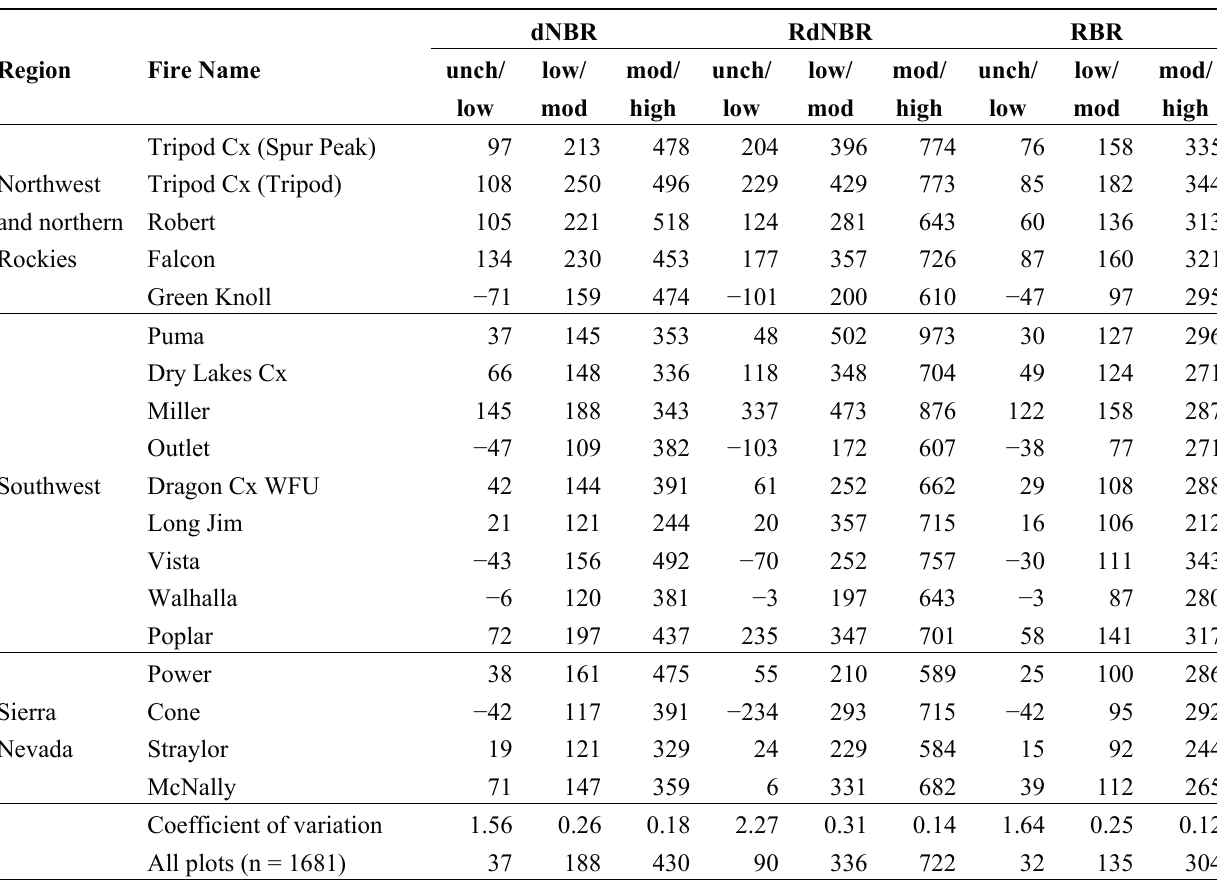
Table A2. Thresholds for the three remotely sensed burn severity metrics when the dNBR offset term was excluded from the equations corresponding to CBI = 0.1 (unchanged/low), 1.25 (low/moderate) and 2.25 (moderate/high) for each